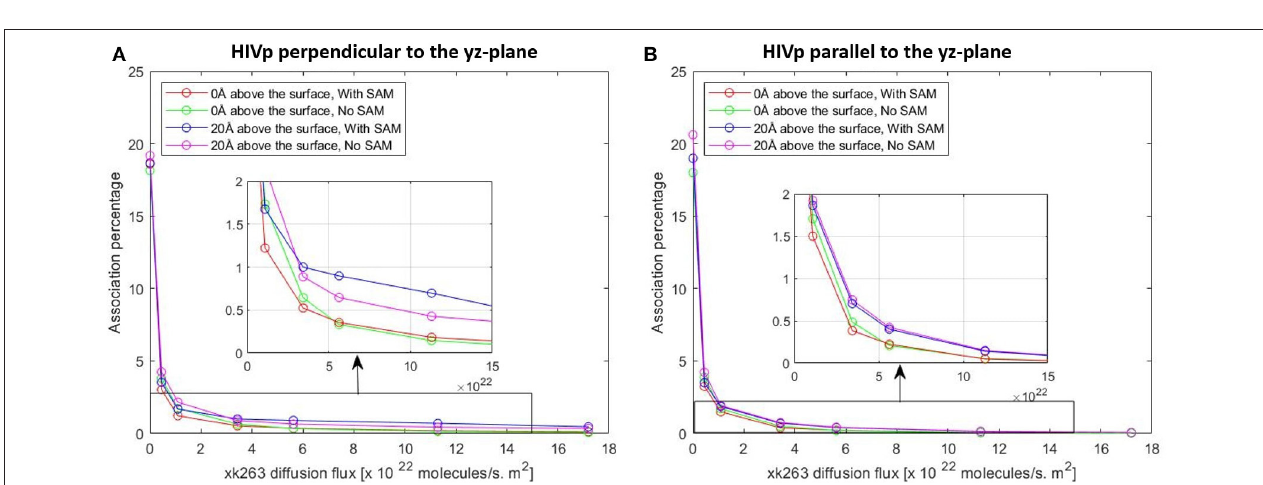
FIGURE 7 | Plot of average association time vs. xk263 diffusion flux. HIVp is placed (A) perpendicular to the yz-plane and (B) parallel to the yz-plane; Similar data imply no effect of HIVp orientation on the association time. In each plot, coinciding lines (red, green, blue, and magenta) show no effect of hydrophobic CH 3 -SAM or height of the receptor from the surface.